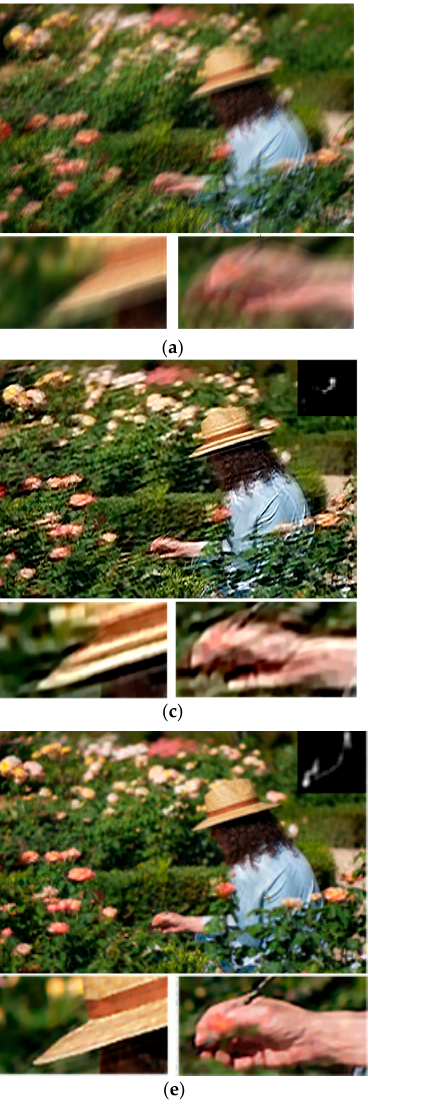
( f ) Figure 10. Comparison of different restoration algorithms on the Buddha image. ( a ) Real blurred image, ( b - f ) are the restored results of the region in the box in ( a ); ( b ) result of Fergus et al. [3]; ( c ) result of Shan et al. [4]; ( d ) result of Cho and Lee [6]; ( e ) result of Xu and Jia [7]; and ( f ) result of our algorithm. In addition to the capability in dealing with the blurred image containing rich textures and small details, our algorithm also can deal with large blur kernels, as shown in Figure 12. Figure 12a is the blurred wall image which contains large motion blur and small details. Due to the large blur, the method of [3] cannot estimate the blur kernel accurately and the restored latent image still contains